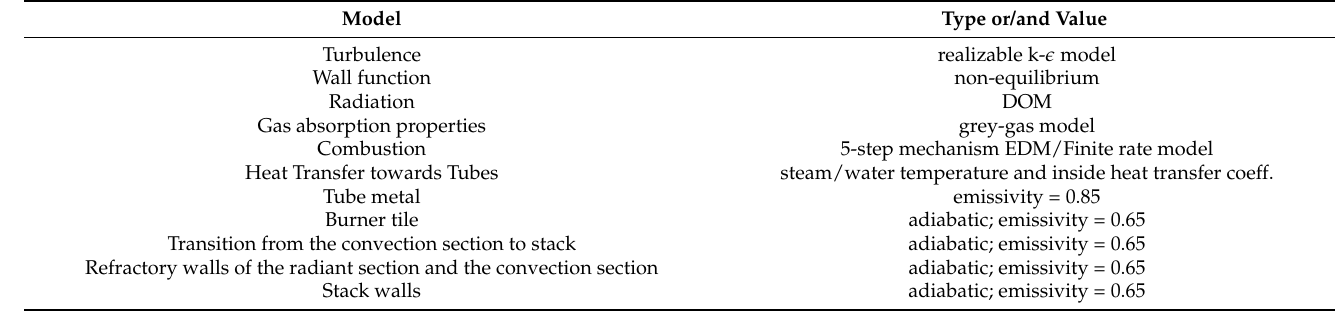
Table 6. Basic setup of CFD model in ANSYS Fluent